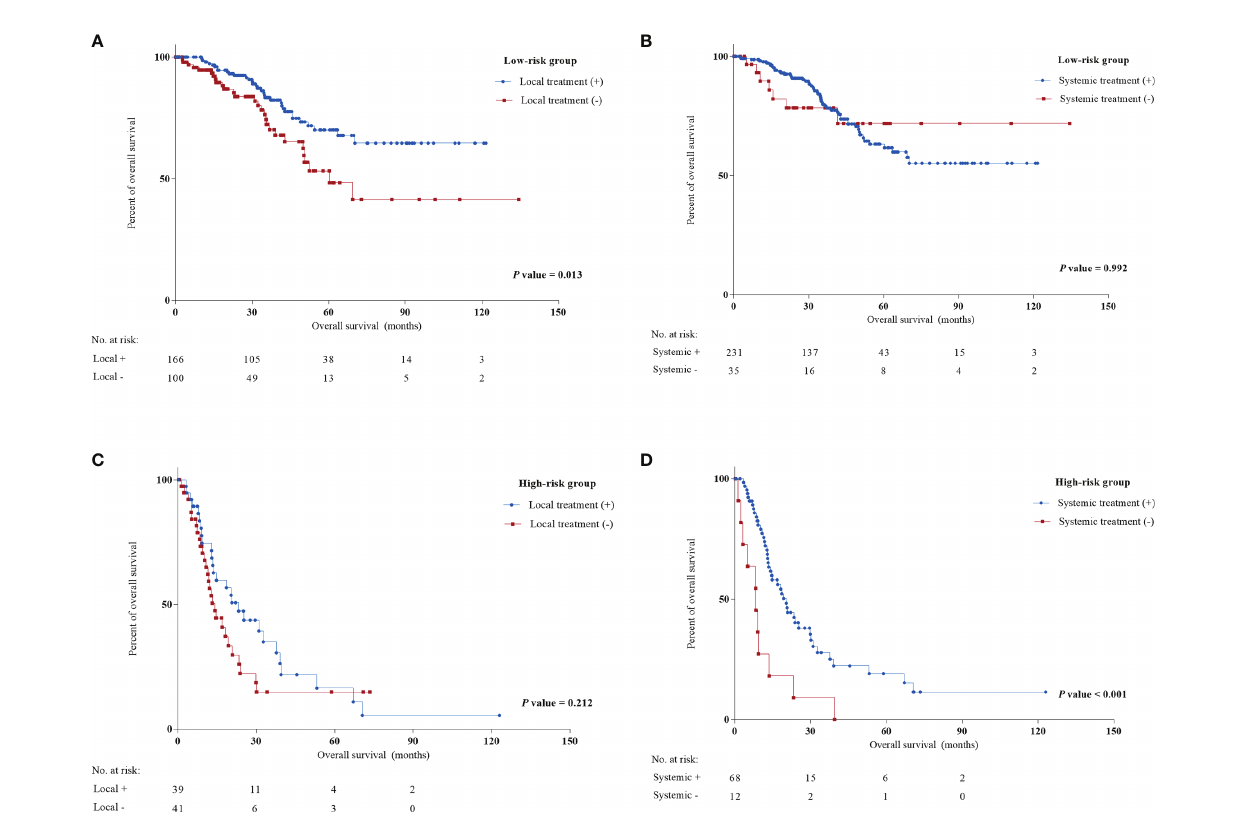
FIGURE 3 | Univariate Cox regression analysis of local treatment and systemic treatment in low and high-risk groups from the training cohort. (A) Local treatment in low-risk group; (B) systemic treatment in low-risk group; (C) local treatment in high-risk group; (D) systemic treatment in high-risk